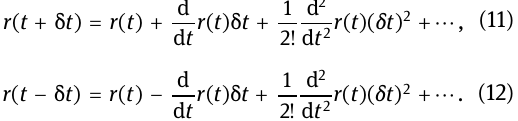
Figure 10 is the general work fl ow of MD simulation, including initialization, energy minimization, equilibrium phase, and production phase [ 220 – 224 ] . In the fi rst stage, we de fi ne preliminary information and simulation details [ 225 ] . Then the energy minimization step is to fi nd the minimum energy level of the system [ 226 ] . In the equilibrium phase, the particles in the system are relaxed to the equilibrium state by changing the input and output energy [ 227,228 ] . Finally, in the production phase, trajectory data are collected and perfor - mance is analyzed [ 229 ] .